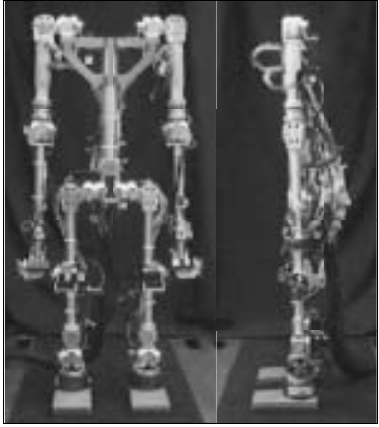
Figure 7 Gorilla Robot II.